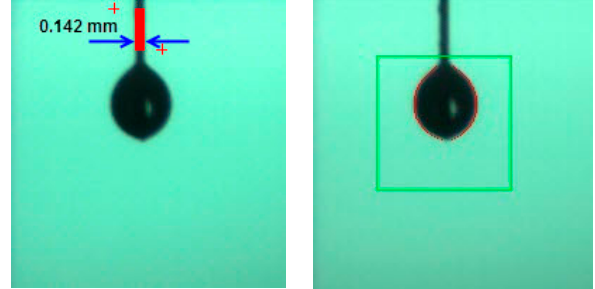
Figure 2. A sample image of the droplet.